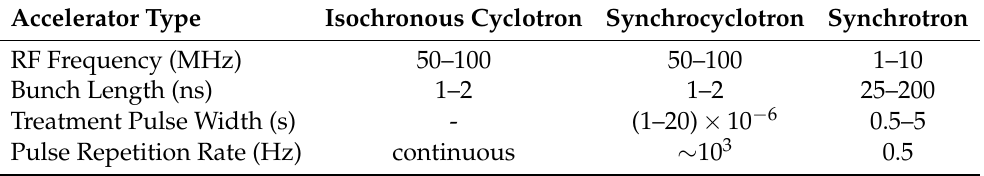
Table 1. Typical beam time structure for different clinical